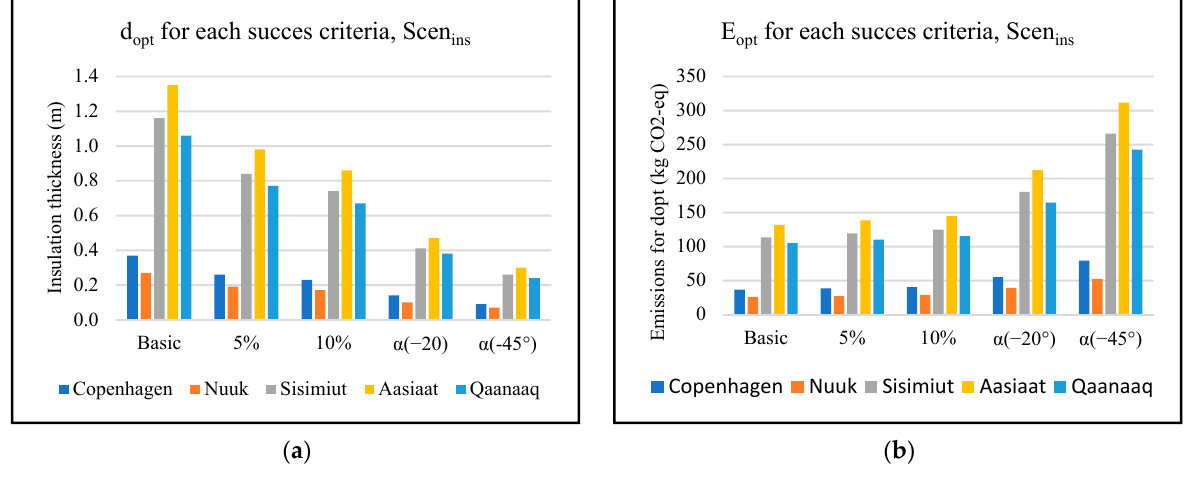
Figure 8. Thickness ( a ) and emissions ( b ) for different success criteria for Scen ins with Mineral wool batts and district heating.